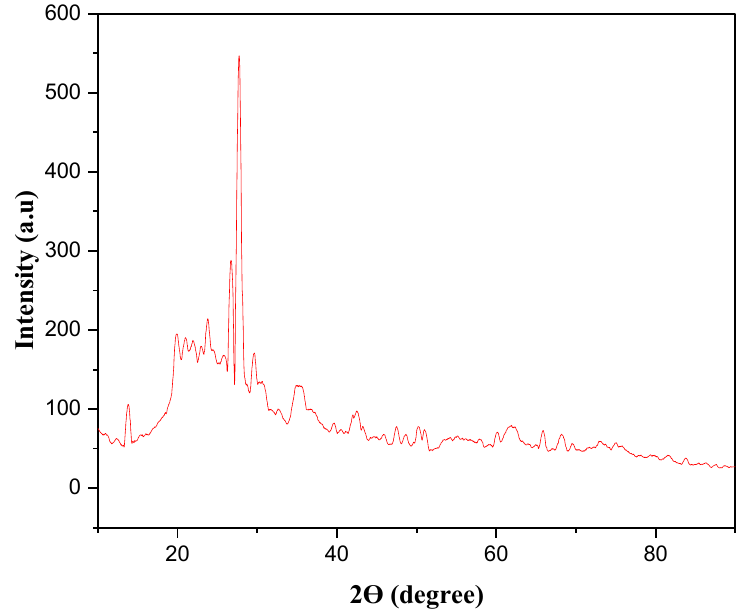
Figure 4. The TMS’s XRD patterns.